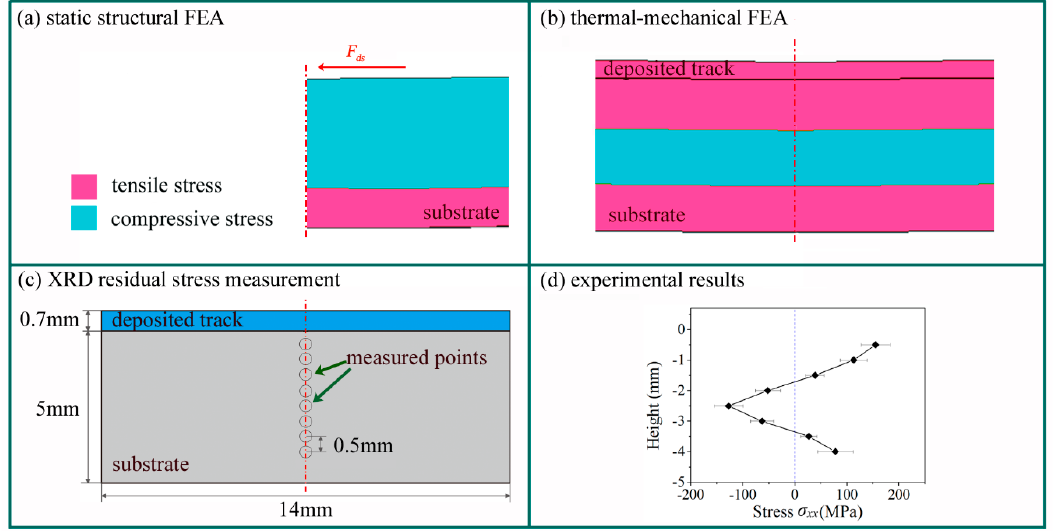
Figure 4. The distribution of stresses σ xx fouind via the three methods. ( a ) The stress distribution in the static structural FEA model (half of the substrate). ( b ) The distribution of residual stresses in the thermal-mechanical FEA model. ( c ) The measured points of XRD residual stresses tests. ( d ) The experimental residual stresses along the center line.